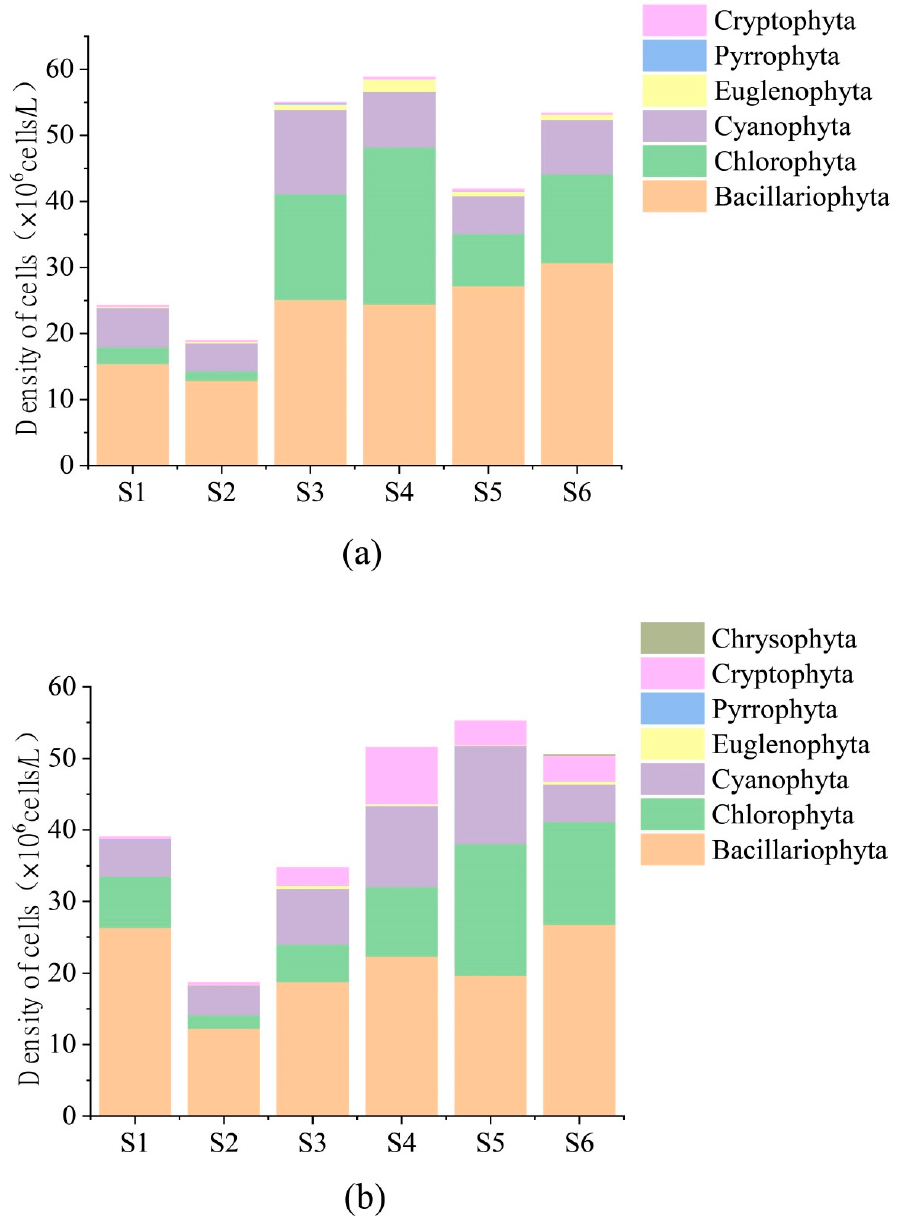
Figure 3. Changes in abundance of periphytic algae at each sampling point during the wet ( a ) and dry ( b ) seasons. dry ( b )